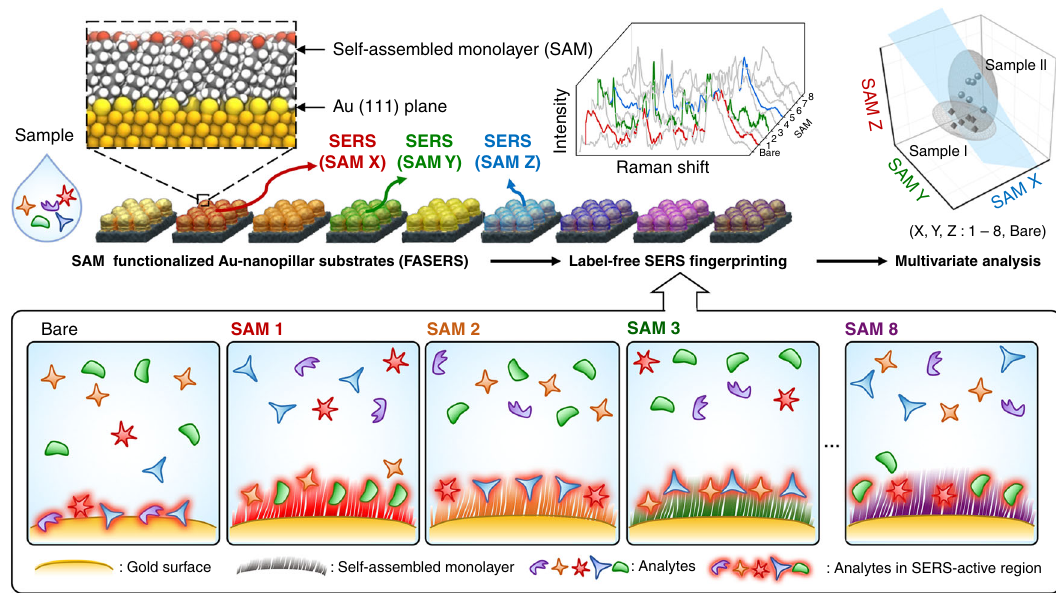
Fig. 1 Schematic illustration of arti fi cial-nose-empowered surface-enhanced Raman spectroscopy. ‘ Functionalized Array for Surface-Enhanced Raman Spectroscopy (FASERS) ’ represents an array of plasmonic surfaces for label-free SERS presenting different self-assembled monolayers. A range of molecular interactions takes place within complex biological media at each unit sensor where mildly selective SERS enhancement of the constituents gives multiplexed spectral datasets. The increased data dimensionality obtained enables facile identi fi cation of closely related